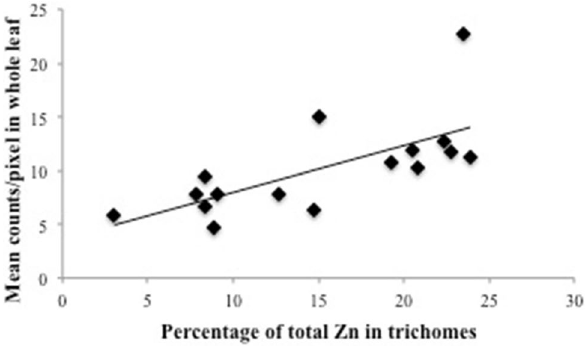
Figure 5. Zn accumulation in trichomes increases with Zn in leaves. Correlation of the percentage of the total Zn in trichomes with mean Zn counts in whole leaf of 16 A. thaliana accessions. All plants were cultivated under 50 µM Zn, and the 7th true leaf was